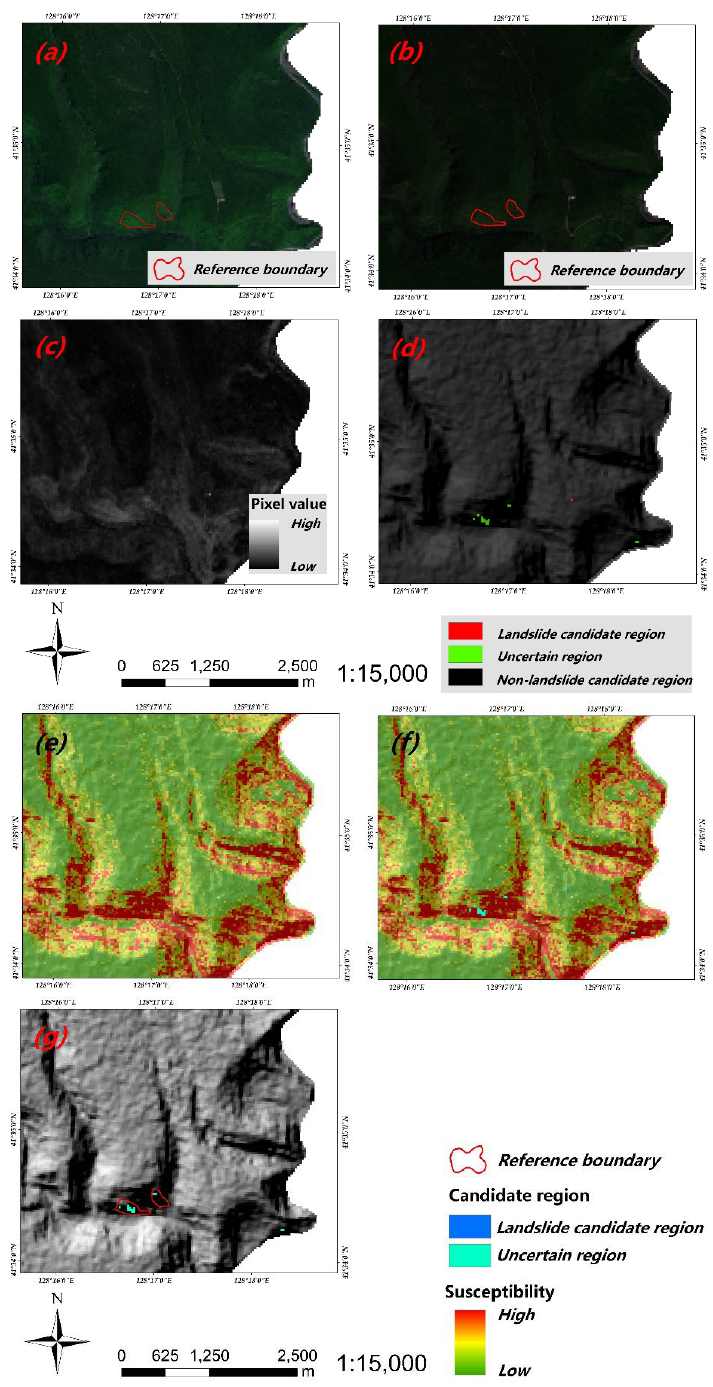
Figure 16. Landslide identification results in sub-area B. ( a ) Pre-event images; ( b ) post-event images; ( c ) difference image; ( d ) thresholding results; ( e ) susceptibility results; ( f ) overlapping; ( g ) final